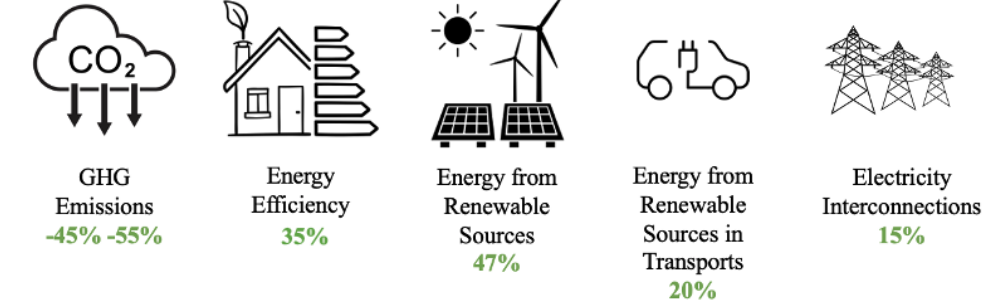
Figure 1. PNEC national targets for 2030, adapted with permission from Ref.